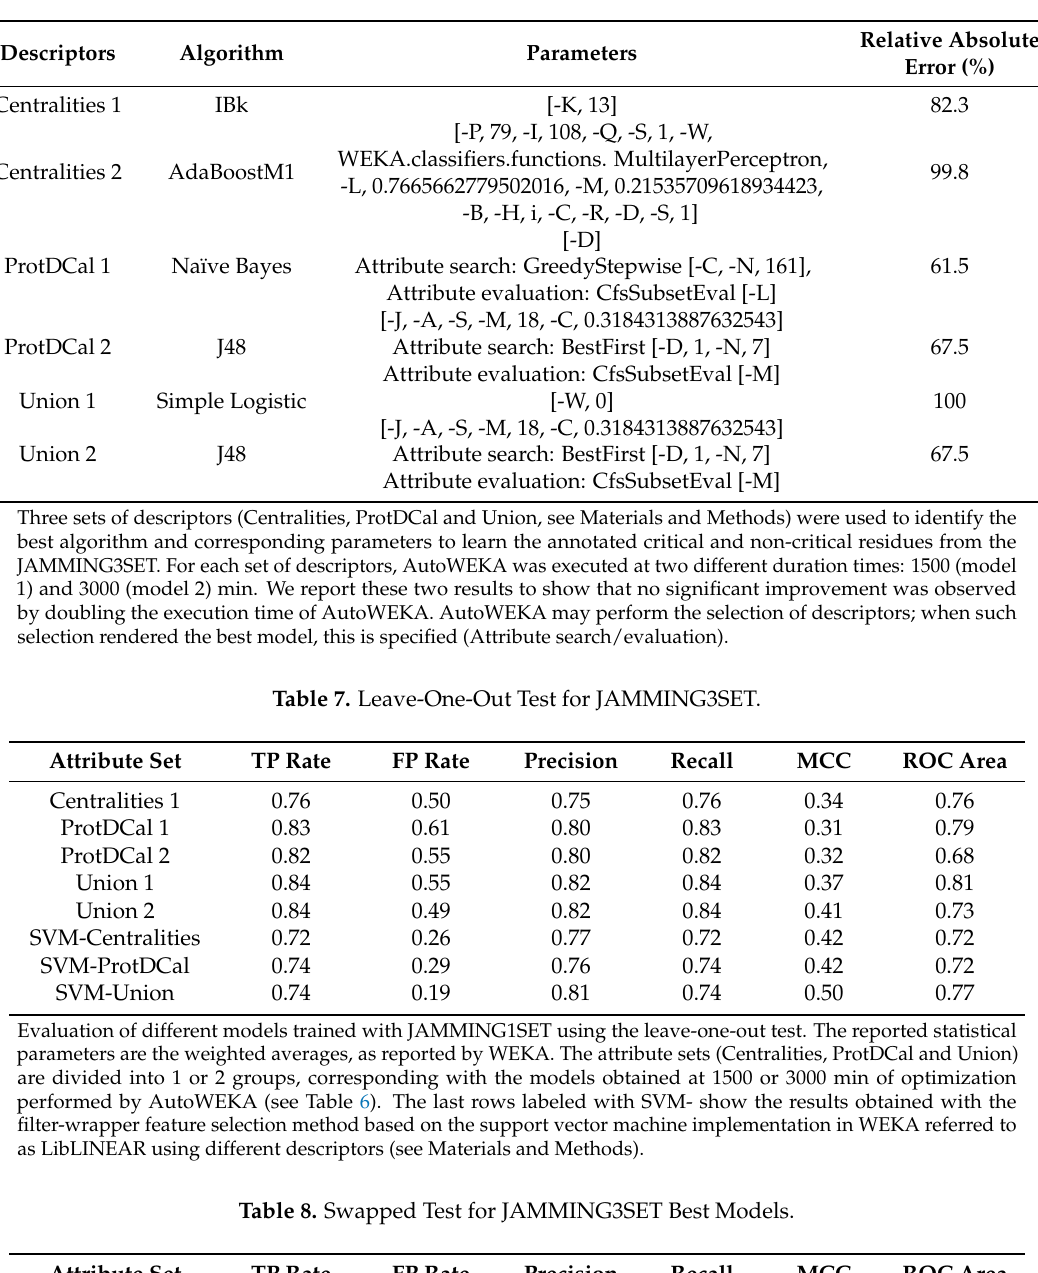
Table 6. Algorithms and parameters optimized for JAMMING3SET.